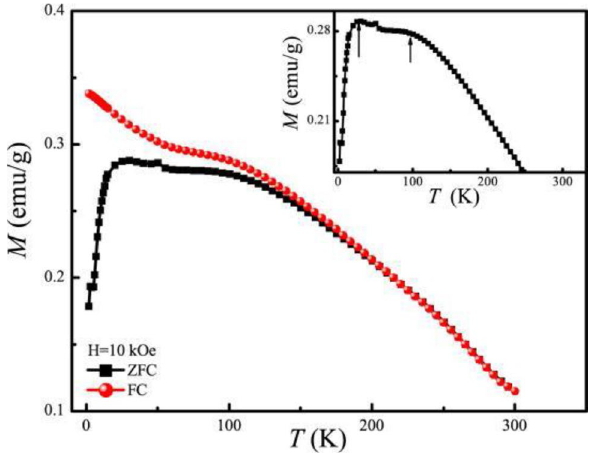
Figure 4. The ZFC and FC curve of BSCFO bulk under H = 10 kOe.